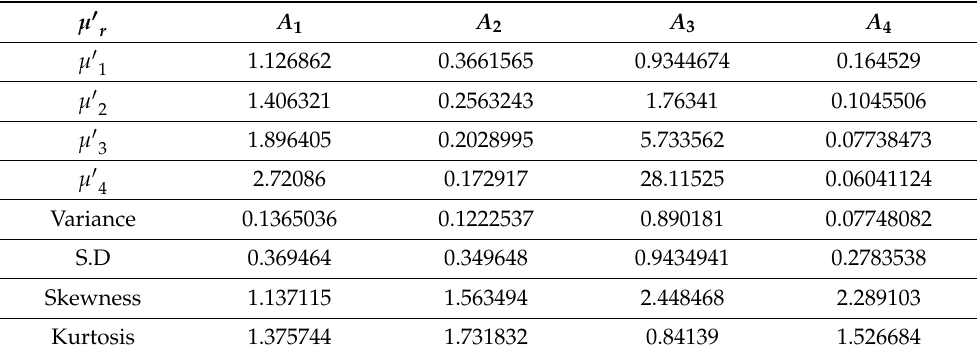
Table 1. Moments, variance, standard deviation, skewness and kurtosis of X for randomly selected parameter values of minLLx( θ , λ , β